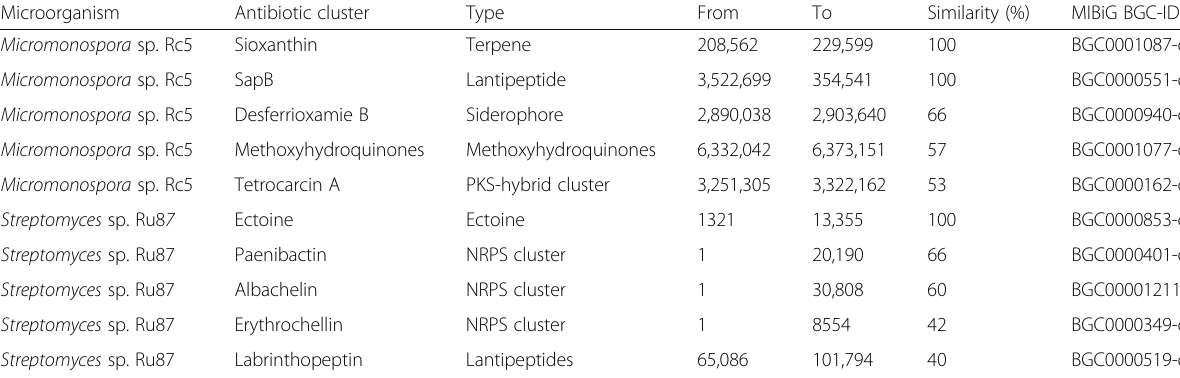
Table 3 Gene annotation of Micromonospora sp. Rc5 and Streptomyces sp. Ru87 whole genomes using the antiSMASH 3.0.5 database showing the highest similar biosynthetic cluster hits